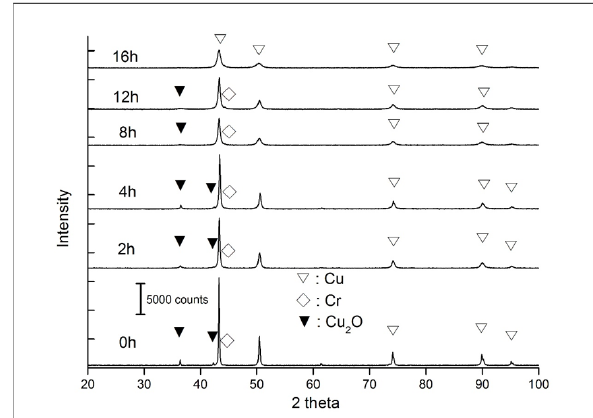
Figure 1: XRD patterns of the milled powder obtained as a function of milling times up to 16 h.